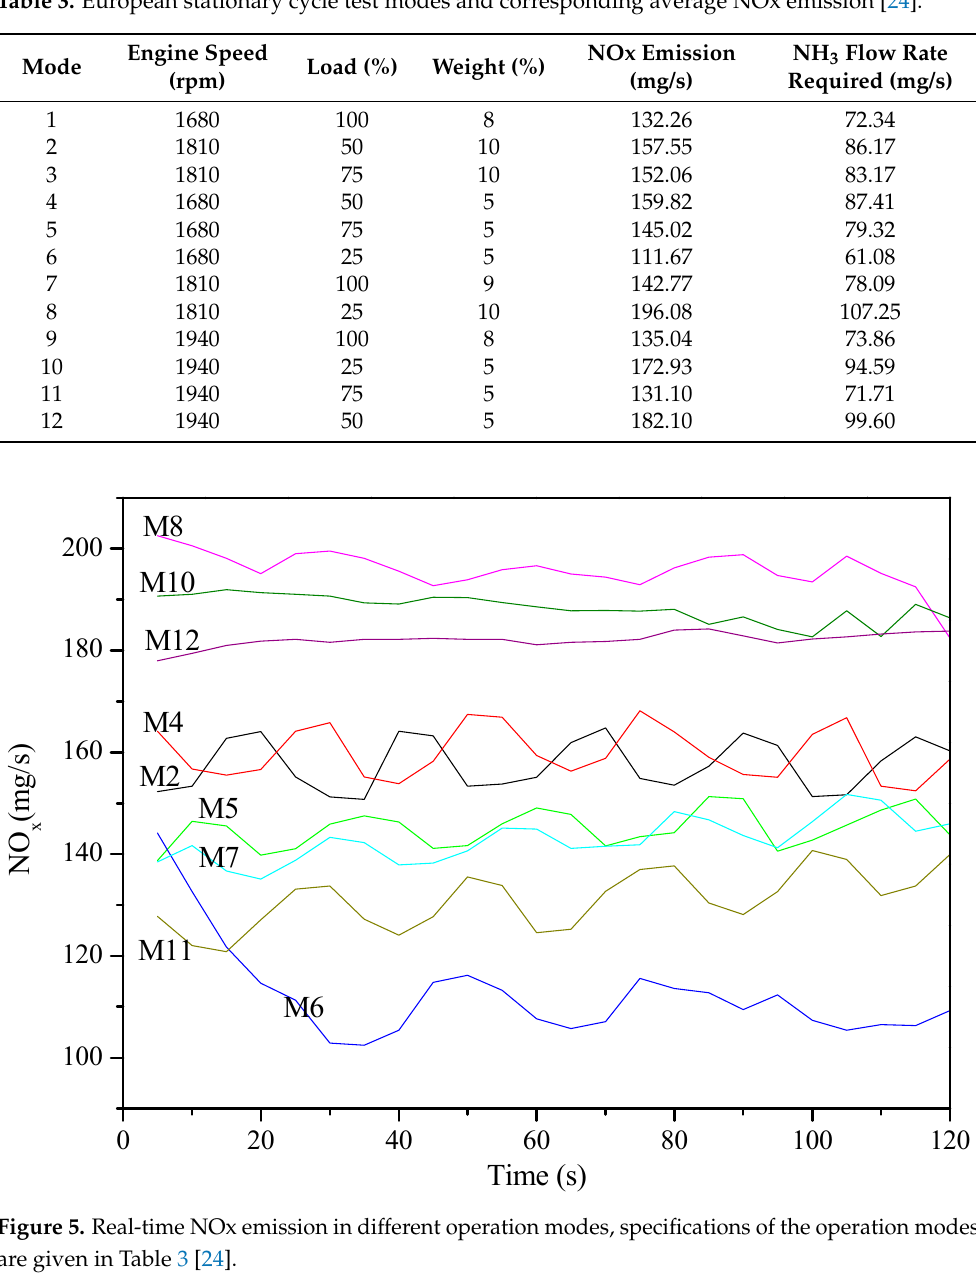
Table 3. European stationary cycle test modes and corresponding average NOx emission [24].